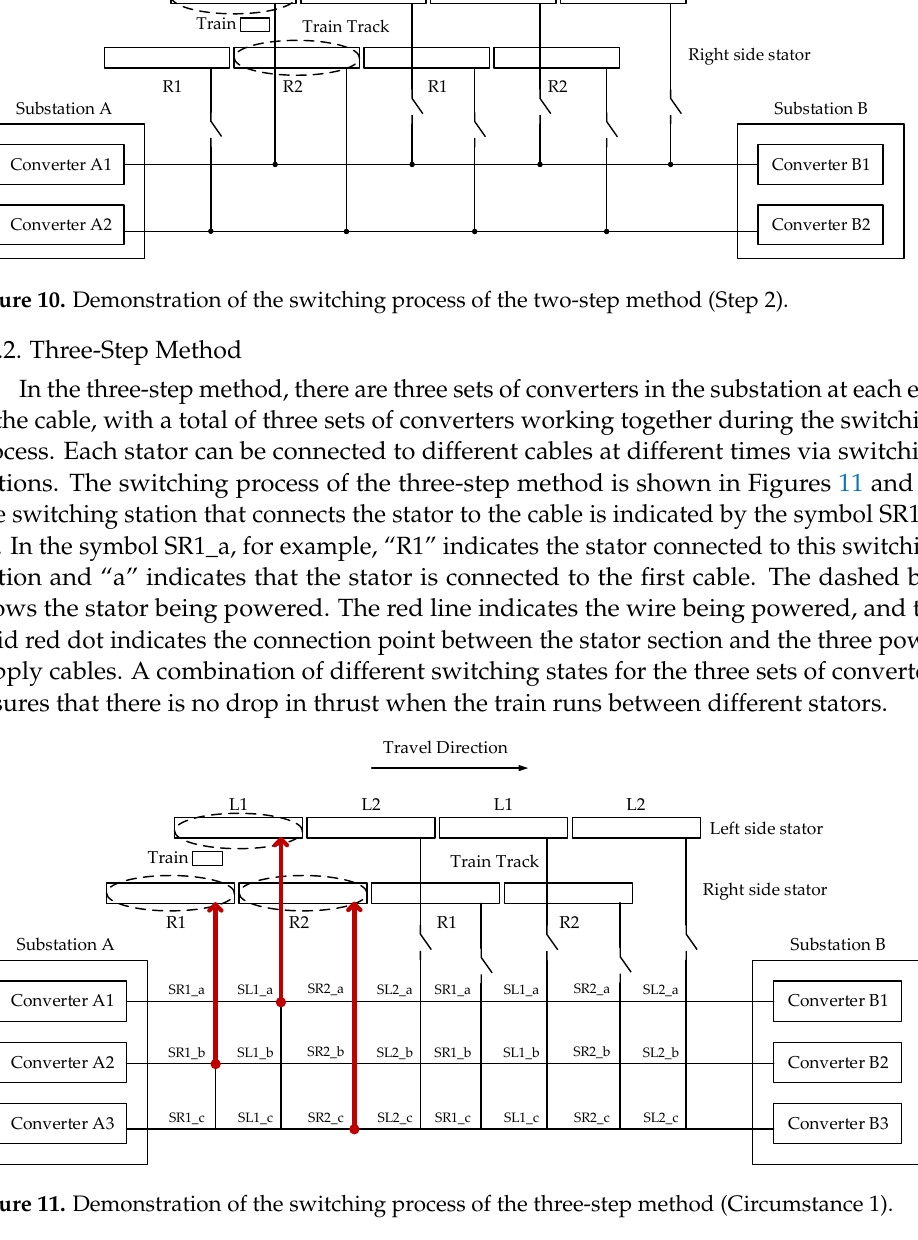
Figure 9. Demonstration of the switching process of the two-step method (Step 1).